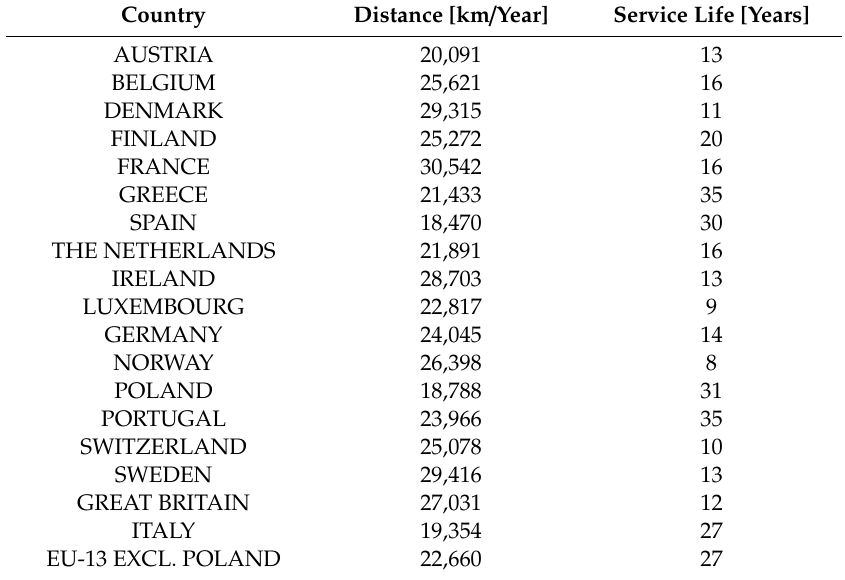
Table 5. The service life of the car and the average annual distance travelled by a passenger car in the EU countries, Switzerland and Norway.